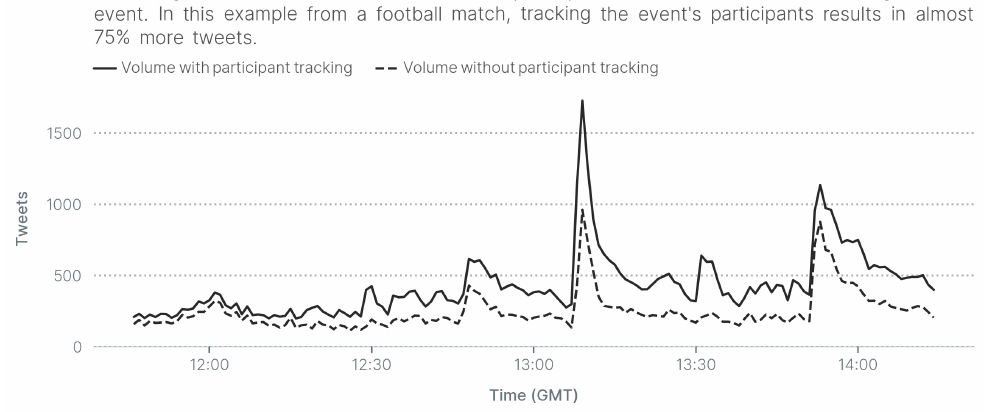
Figure 1. Collecting tweets that mention the event’s participants broadens